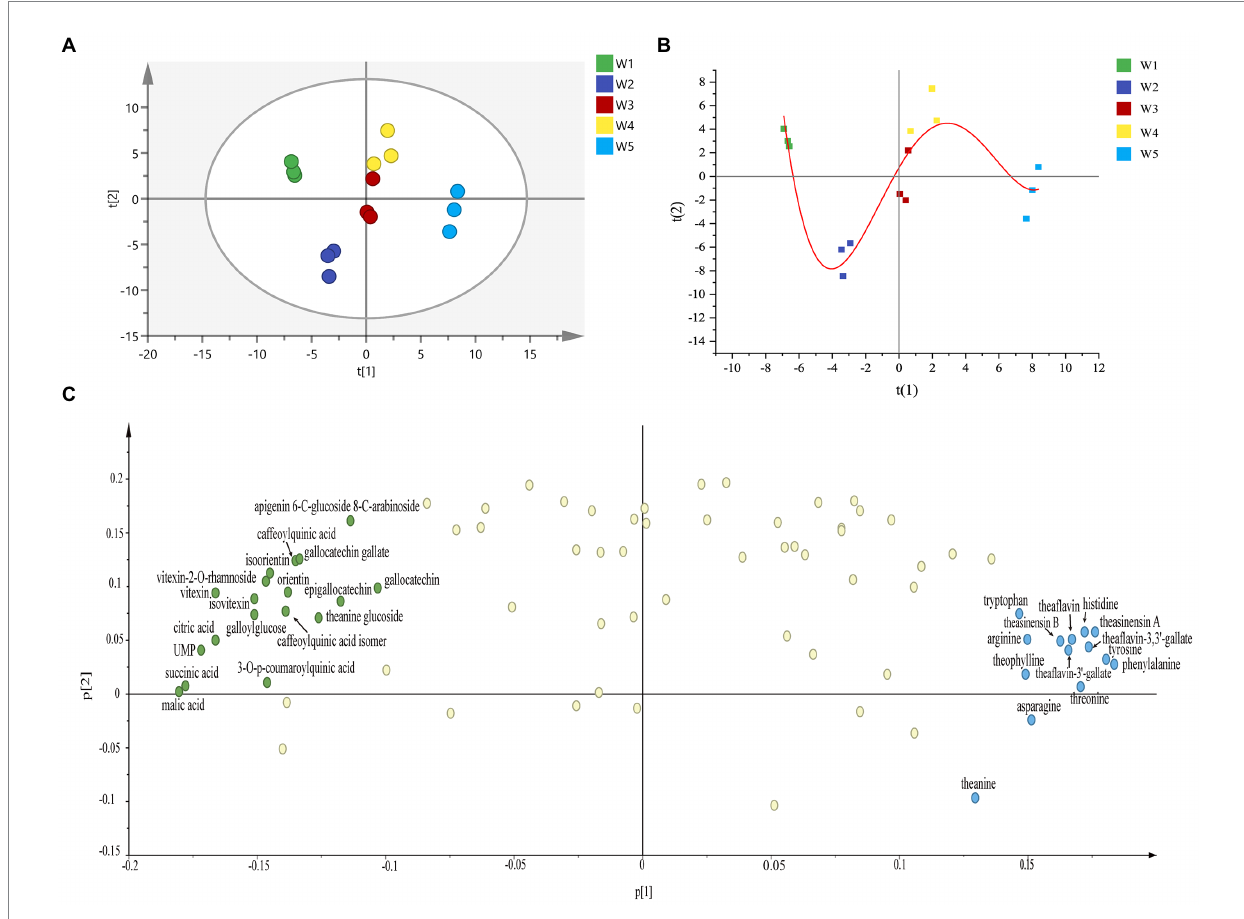
FIGURE 3 Multivariate statistical analysis of Longjing tea samples with different withering degrees. (A) The score plot of principle component analysis (PCA). (B) The metabolic trajectory plot. (C) The loading plot of PCA